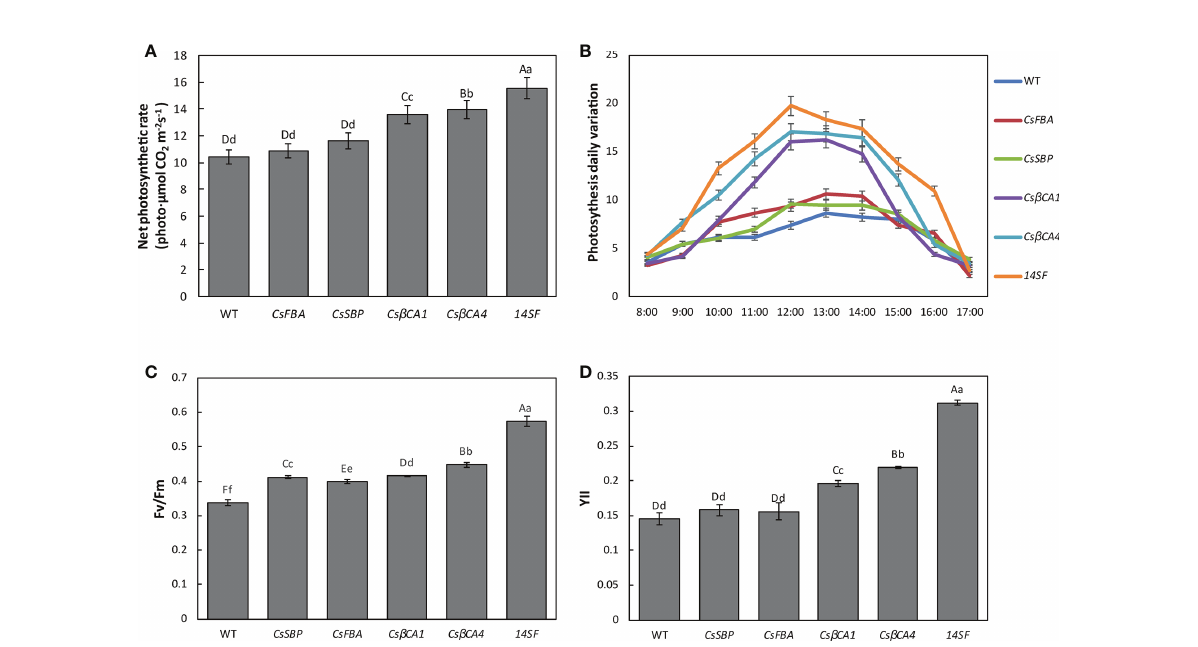
FIGURE 6 Comparison of photosynthetic and rate of WT and transgenic cucumber leaves. The net photosynthesis rate (A) , net photosynthesis rate dynamics in a time-course manner (B) , Fv/Fm (C) and YII (D) were determined. Values represent the means ± SD (n = 3) of three plants per line. Small letters in each fi gure represent signi fi cant differences among samples by Student ’ s t-test (P <